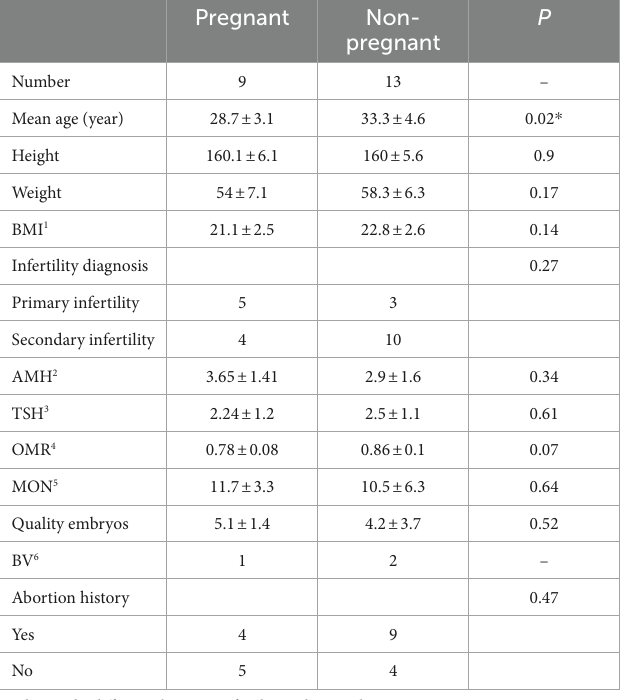
TABLE 2 The baseline characteristics of the infertile patients.